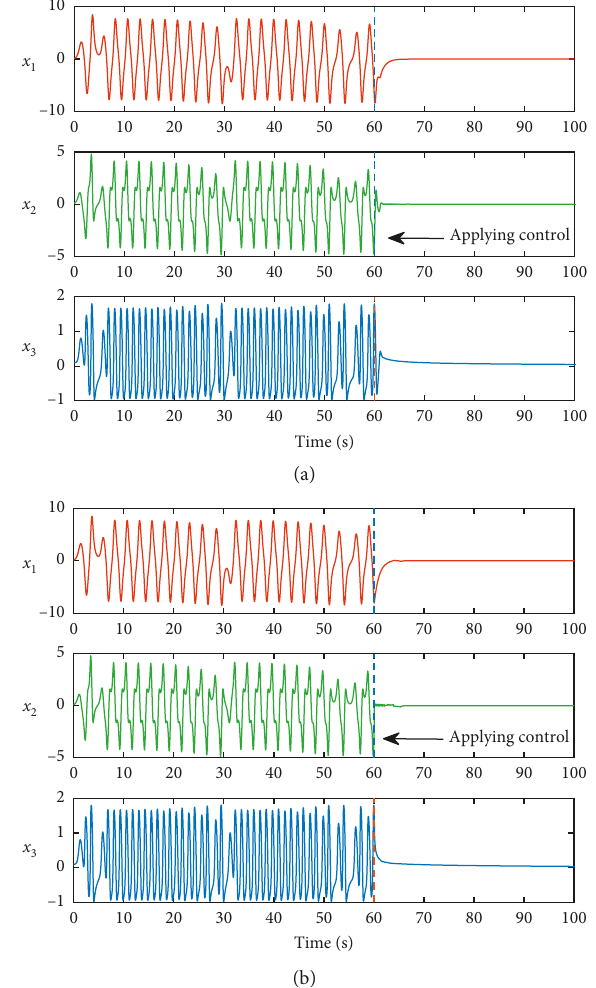
Figure 8: Control results of state variables with (a) K � –2 and